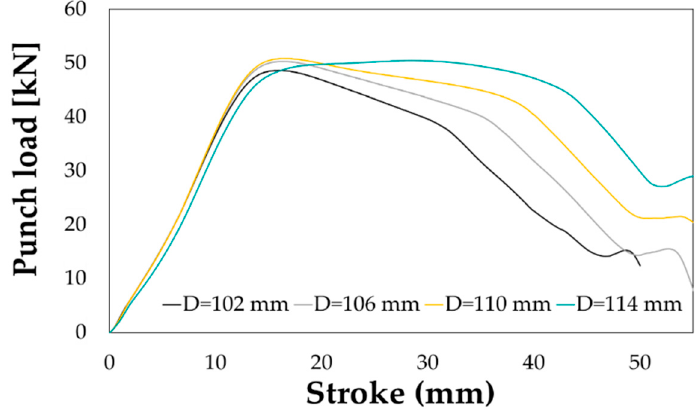
Figure 25. Deep drawing on LHT specimen. Effect of the blank diameter.